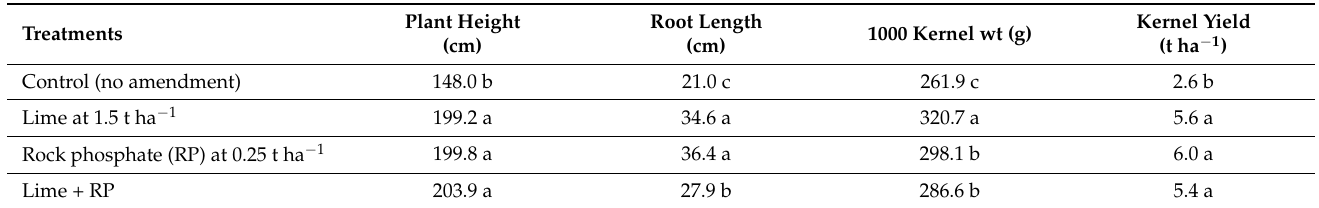
Table 7. Performance of maize under different acid sulphate soil management treatments during Rabi 2018–2019.